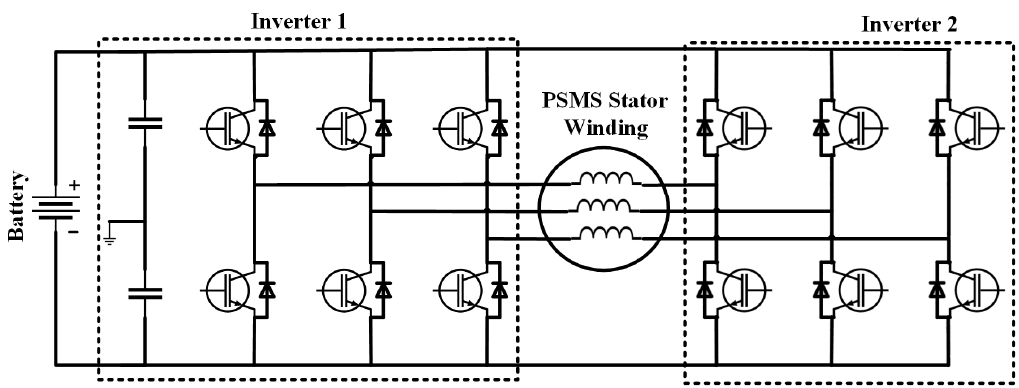
Figure 43. Dual inverter with dual sources [72].